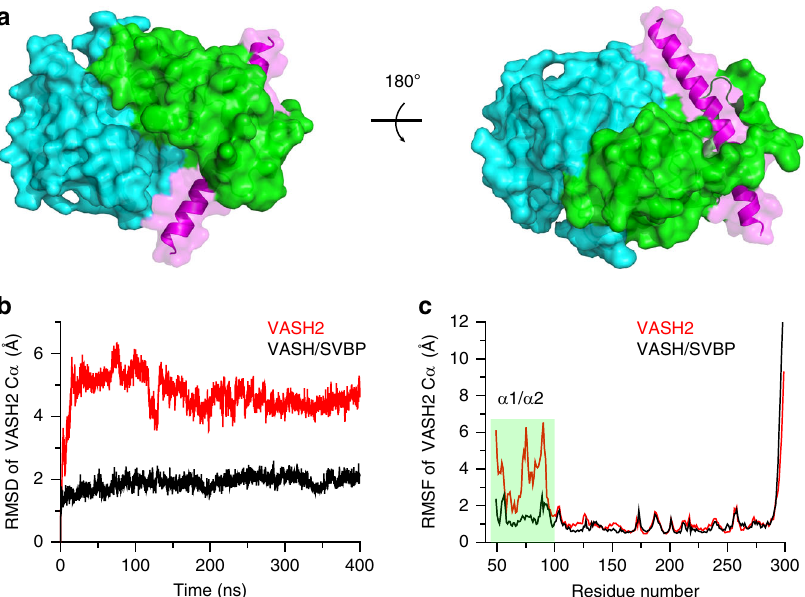
Fig. 3 Dynamics of VASH2 and stabilization by extensive interaction with SVBP. a Surface representation of contacts between VASH2 and SVBP. b Representative RMSD fl uctuations of VASH2 C α atoms in the MD trajectory. The fl uctuation of VASH2 in the presence and in the absence of SVBP is represented by black lines and red lines, respectively. c The root mean square fl uctuation (RMSF) of VASH2 C α atoms during the simulations is calculated with reference to an energy-minimized initial crystal structure. Green shading highlights the α 1- and α 2- helices of VASH2 possessing high RMSF without